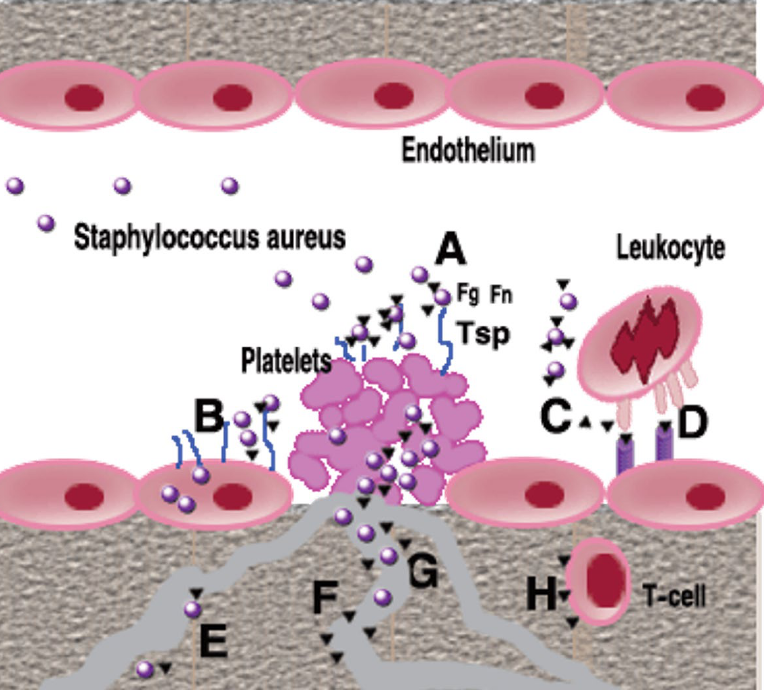
Fig. 7. Role of SERAM in endovascular Staphylococcus aureus infection: During wound infection, S. aureus organisms secreting and/or decorated by secretable extended repertoire adhesion molecules SERAM) (black triangles) gain access not only to the intact vessel wall, but also to subendothelial matrix and activated platelets and will form a bacteria-entrapped platelet clot (A). SERAM bind to various extracellular matrix components including fibrin (ogen) (Fg), fibronectin (Fn) or thrombospondin (Tsp) that are present in this vegetation and thereby augment bacterial attachment through molecular bridging mechanisms (Α). In addition, SERAM may facilitate bacterial binding to Fn expressed on endothelial cells resulting in enhanced uptake of microorganisms (Β). Through interaction with complement factor C3, the extracellular fibrinogen binding molecule (Efb) may interfere with opsono-phagocytosis (C). Among other interactions with host factors, the extracellular adhesion protein (Eap) binds to ICAM-1 and other ligands on endothelial cells thereby inhibiting leukocyte adhesion and preventing their extravasation (D). After passaging through the endothelial cell layer and/ or the extracellular matrix stroma, S. aureus may gain access to other capillaries, arterioles and venules, attach to the vessel wall and start disseminating from focal sites of infection (E) Eap may inhibit vascular cell proliferation and angiogenesis possibly via direct interference with agonist-stimulated endothelial functions (F), while Efb interacting both, with platelets and with fibrinogen, may interfere with fibrin formation resulting in altered wound healing (G). Finally, Eap interferes with T-cells function shifting towards a Th2-cell response and reducing delayed- type hypersensitivity reactions [42, 43]